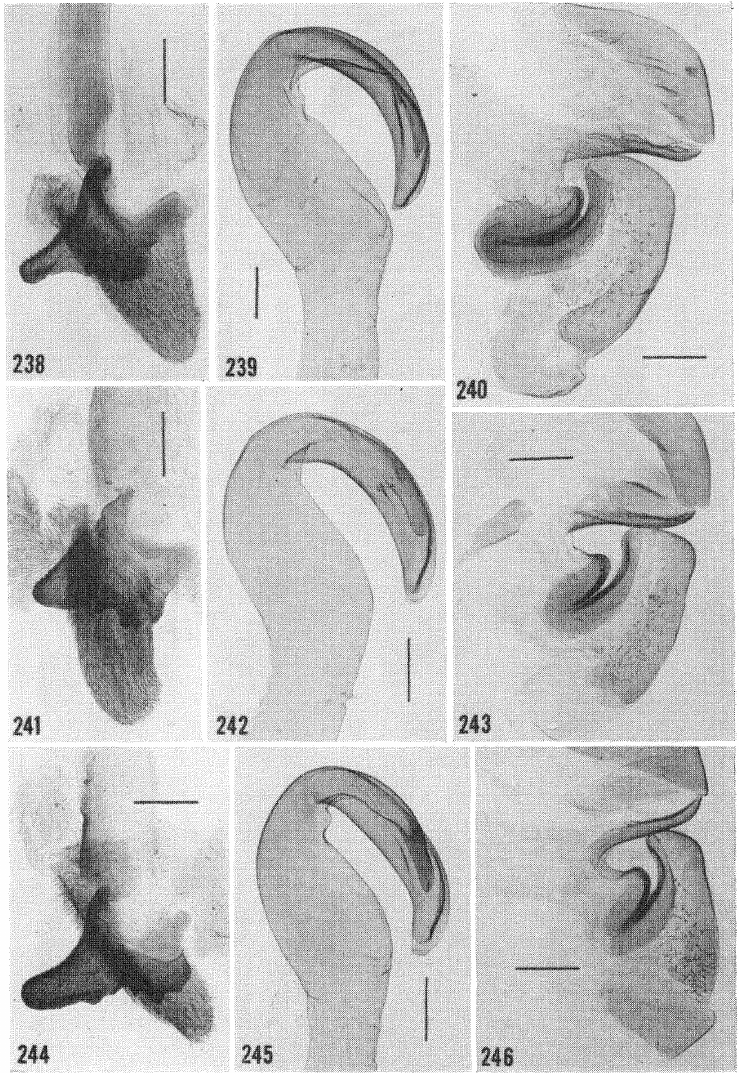
Figs. 238-246. Cockroach male genitalia. 238-240. (18 CUZM). Epi- lampra thunbertTi. Rio de Janeiro, Brazil (det. Prineis). 241-243. (11 BMNH). E. thunbertTi. Theresopolis, Santa Catarina, Brazil (det. Princis; thi specimen was determined as E. testacea Brunner by Hebard). 244- 246. (18 BMNH). Epilampra castanea (det. Prineis; this specimen was determined as "’Epilampra" puncticollis Walker by Hanitsch). (scale z 0.2